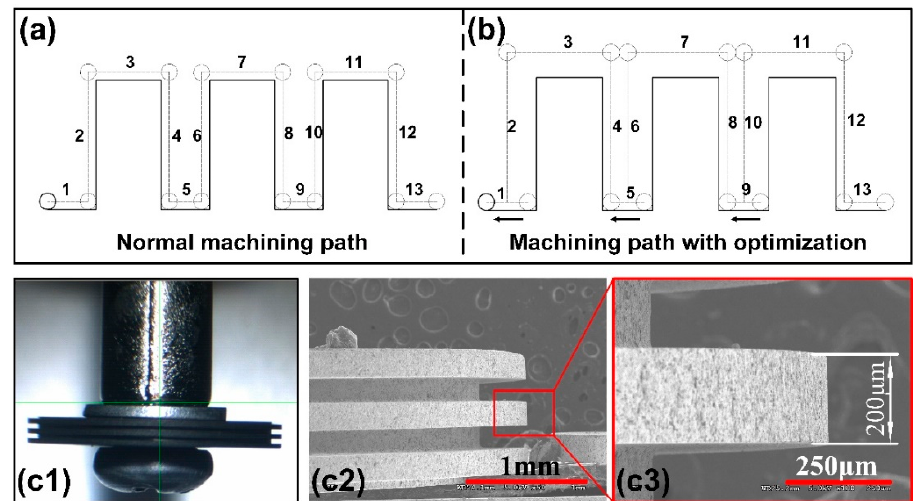
Figure 5. ( a ) The normal machining wire path. ( b ) The machining wire path after optimization. ( c1 ) Digital photograph of the 200 μ m width multi-edges by optimized path. ( c2 ) SEM image of the multi-edges disk electrode. ( c3 ) The enlarged view of ( c2 ).